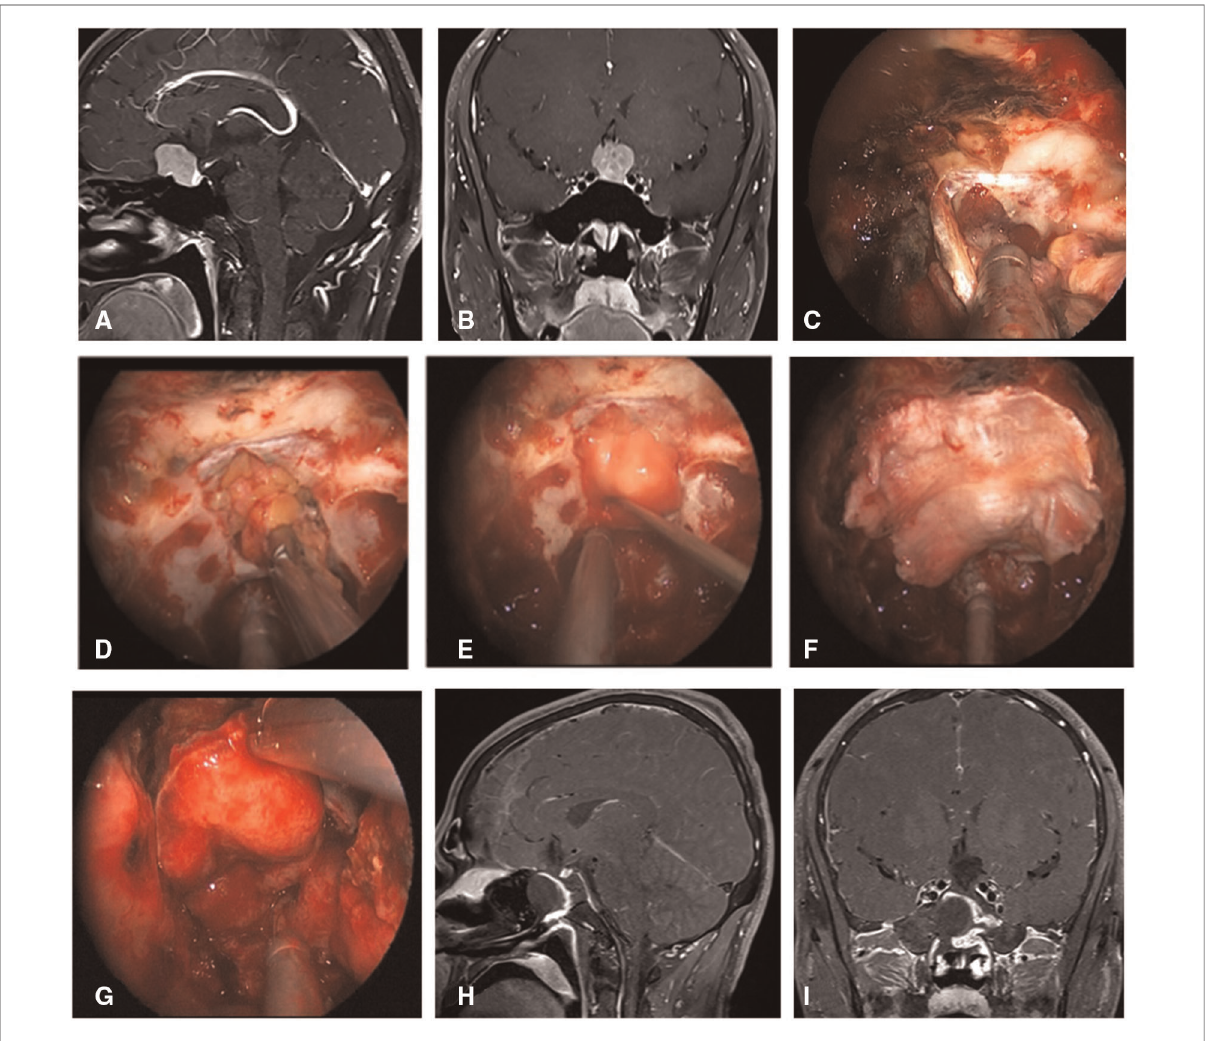
FIGURE 6 Repair process of patient with insuf fi cient embedded fat. ( A,B ) MRI enhanced in sellar region before operation and was considered pituitary adenoma. ( C ) Uncover the VP-NSF to see the subdural leakage. ( D ) Subdural fat packing. ( E ) Arti fi cial dura mater embedded between cellulite and dura mate. ( F ) Cover fascia lata on the arti fi cial inlay dura (arrow). ( E ) Cover the VP-NSF on the fascia lata. ( H,I ) Sagittal and coronal enhanced MRI in sellar region after operation, and postoperative pathology showed pituitary adenoma. VP-NSF, vascularized pedicle nasoseptal fl